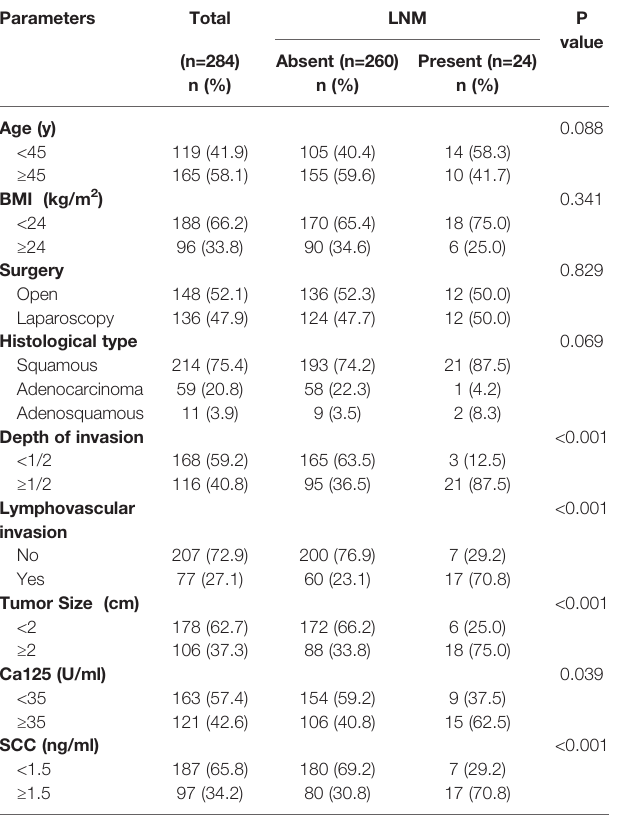
TABLE 1 | Patient Demographics and Clinical Characteristics of CC Patients by LNM. Parameters